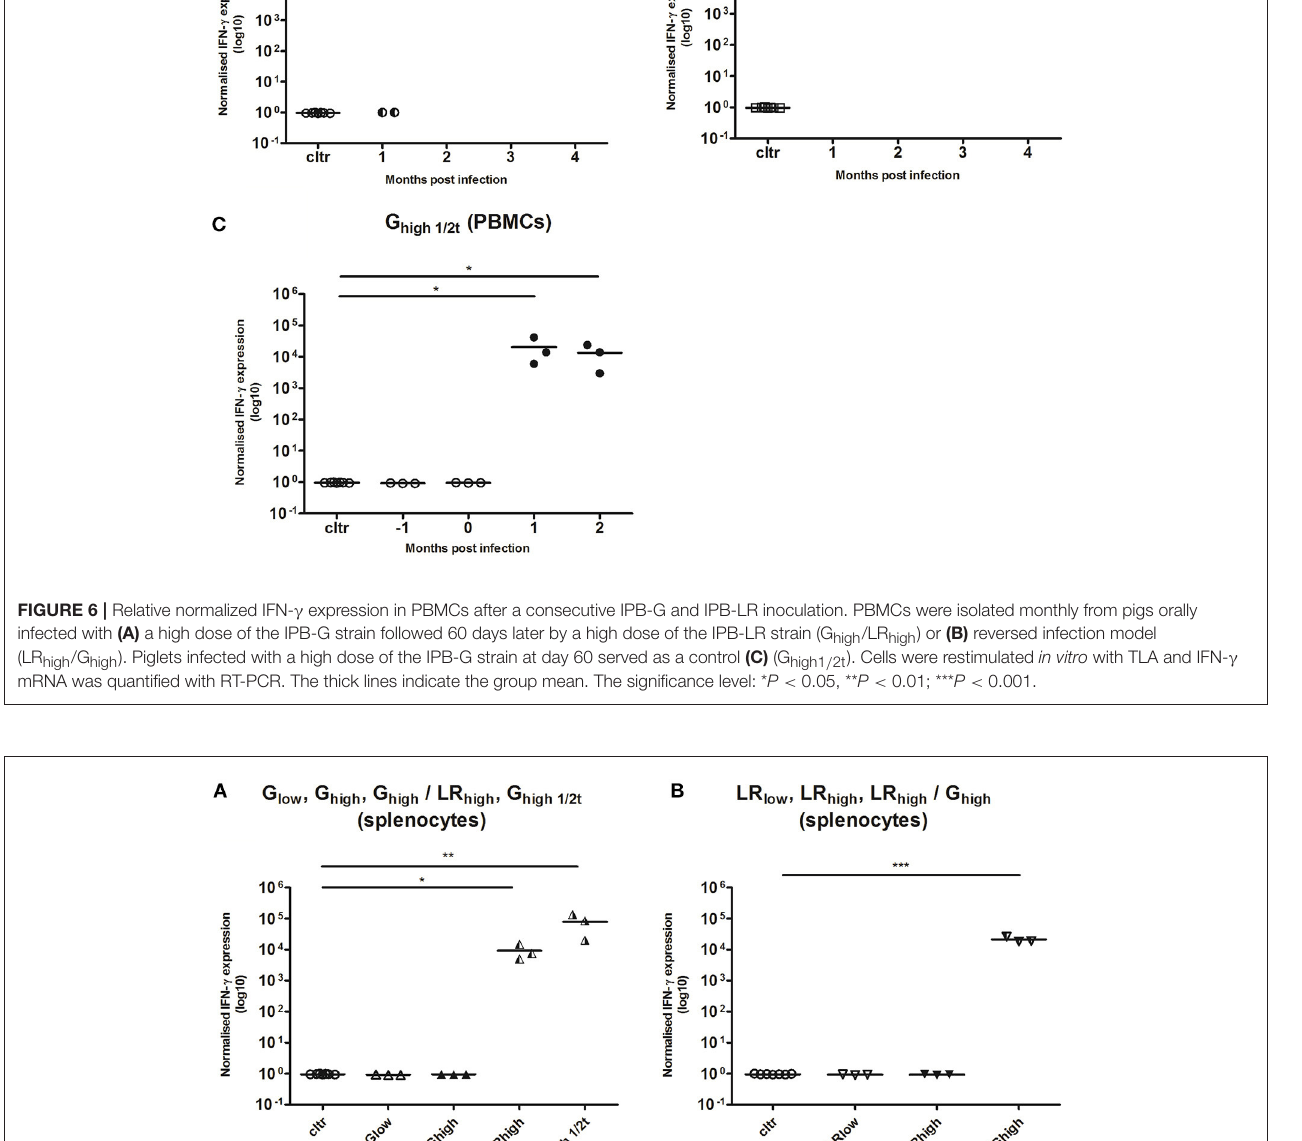
Frontiers in Cellular and Infection Microbiology | www.frontiersin.org